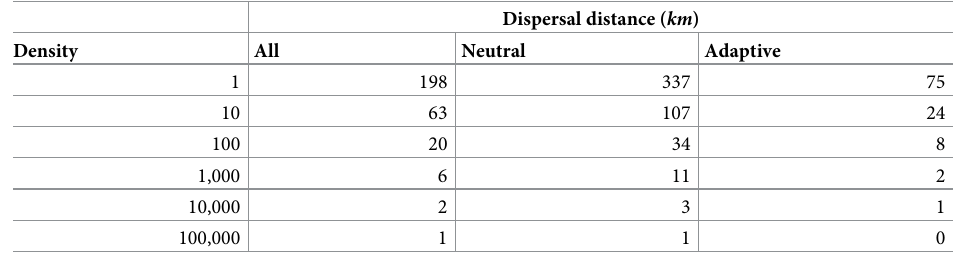
Table 3. Dispersal distance results.